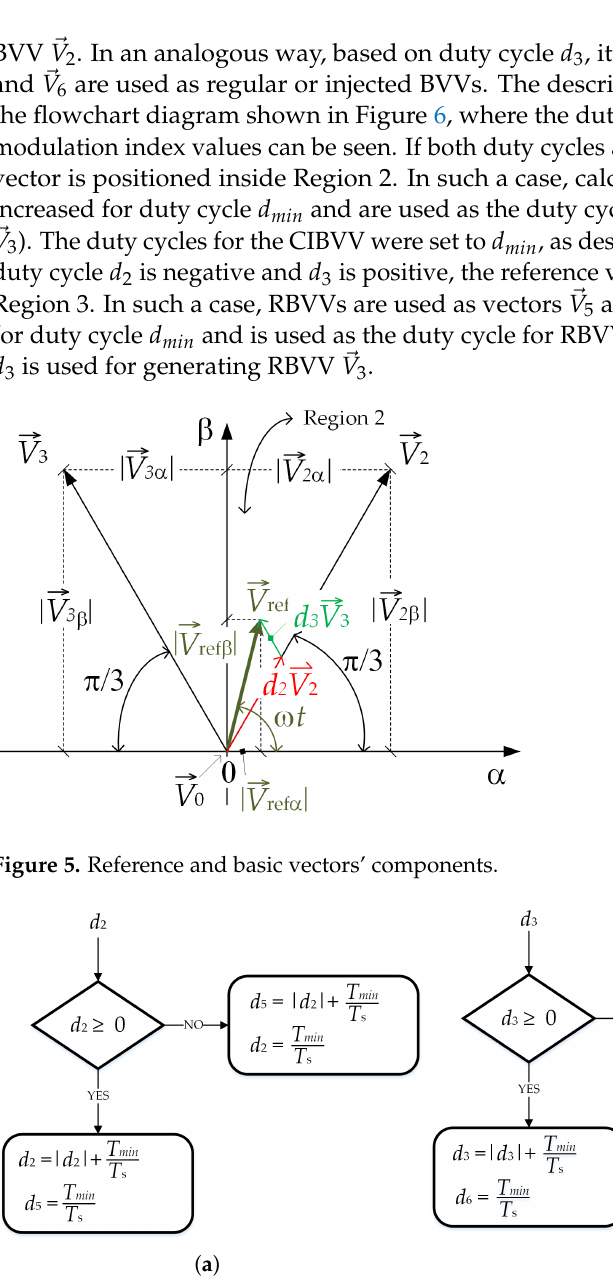
Figure 6. Flowchart diagram for the duty cycle decision when SVM is used for low modulation index operation: ( a ) for d 2 ; ( b ) for d 3